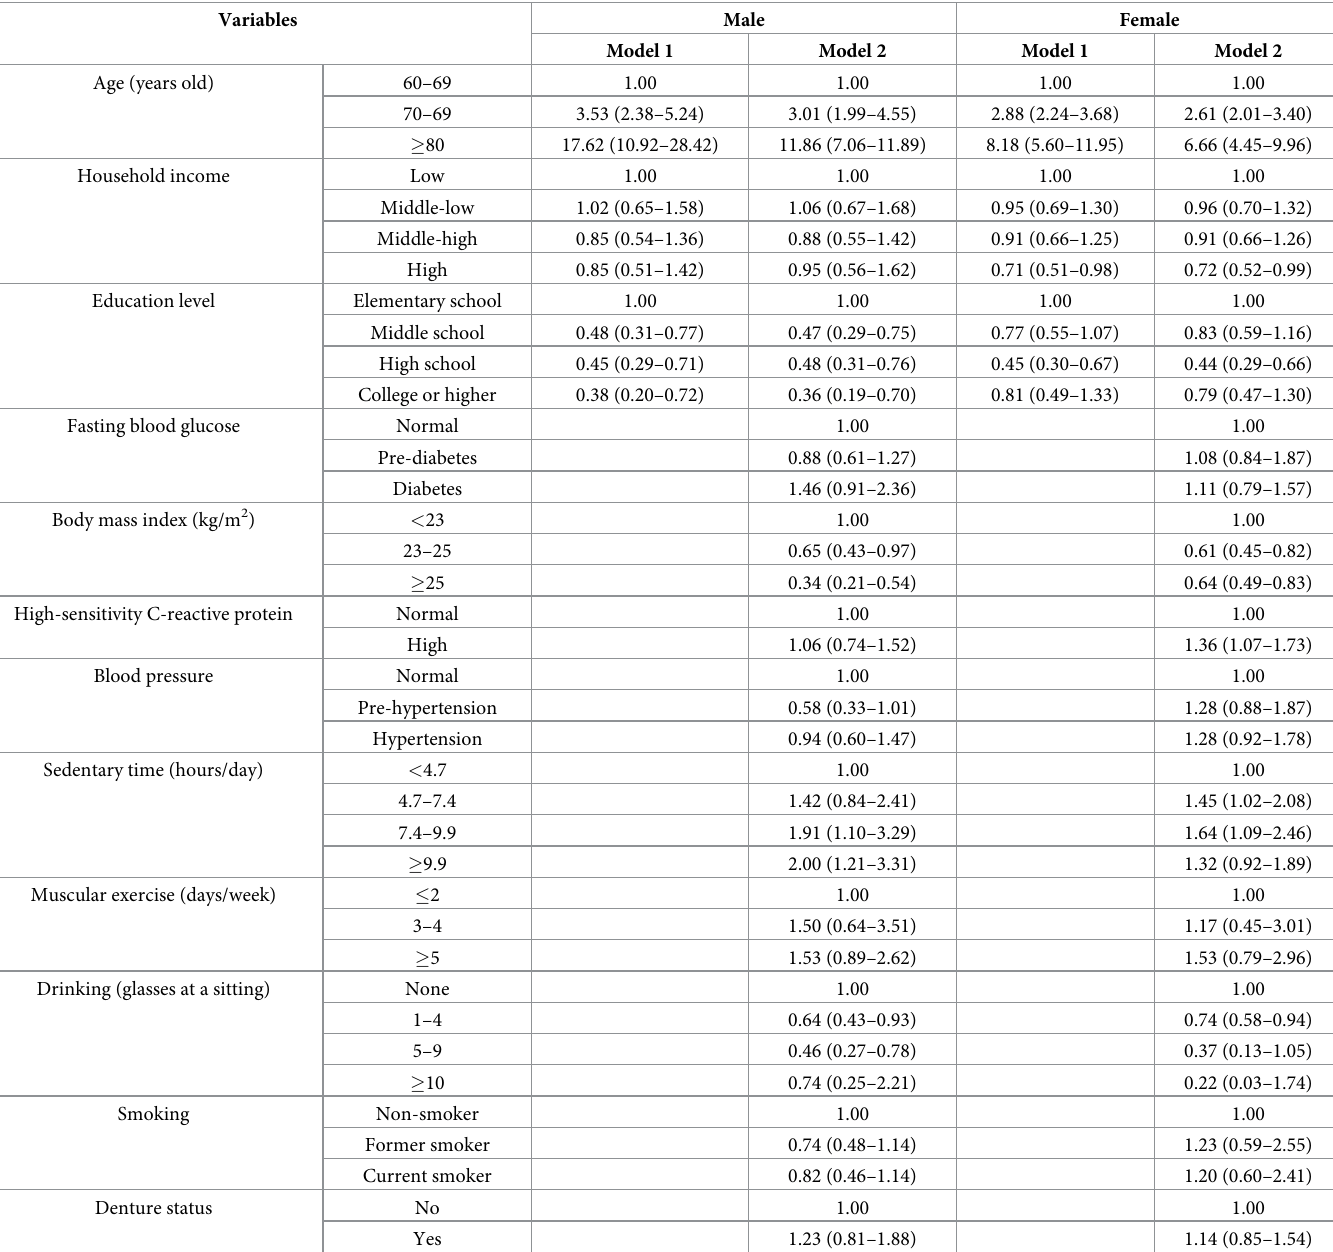
Table 3. Multivariable adjusted logistic regression analysis for evaluating the association with low handgrip strength according to other characteristics of subjects.